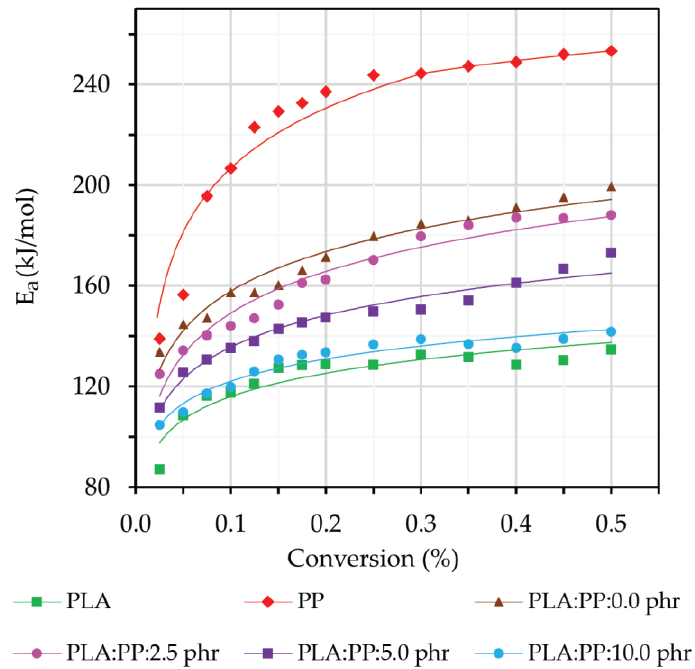
Figure 9. Dependence of the activation energy of PLA, PP, and PLA/PP (70:30 wt%) blends without and with a compatibilizer as a function of the degrees of conversion obtained from the KAS method applied to thermal decomposition.